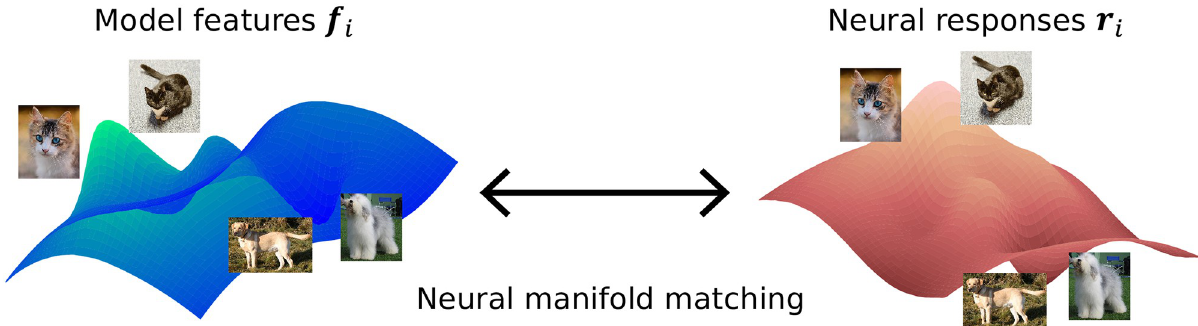
Fig 1. Schematic of neural similarity regularization. Machine learning models are trained so that the stimuli manifold in the model feature space resembles the manifold in the neural response space. The most simple version considers only pairwise relationships among stimuli instances. Two images that are close in the neural response space should also be close in the model feature